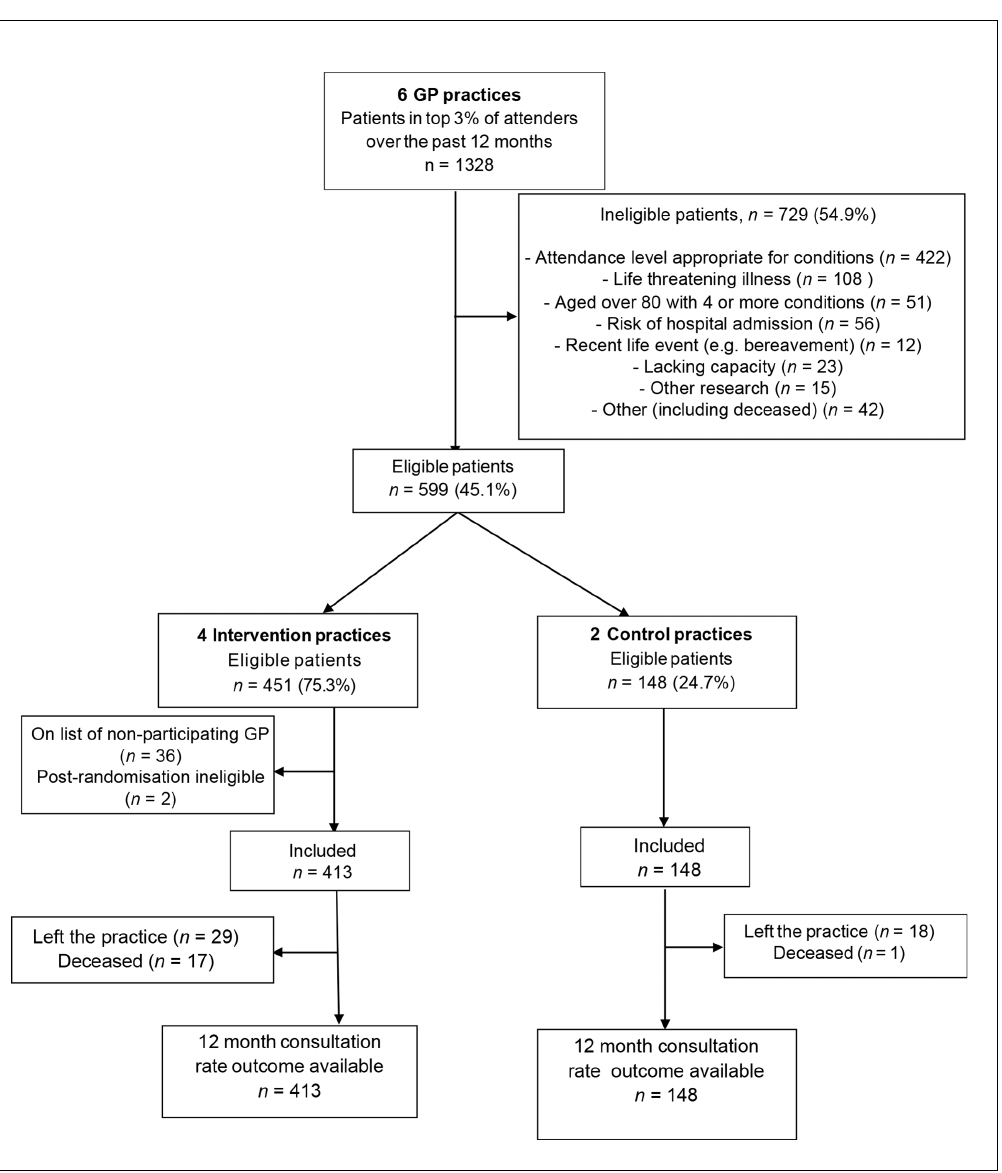
Figure 1 CONSORT flowchart: all eligible patients